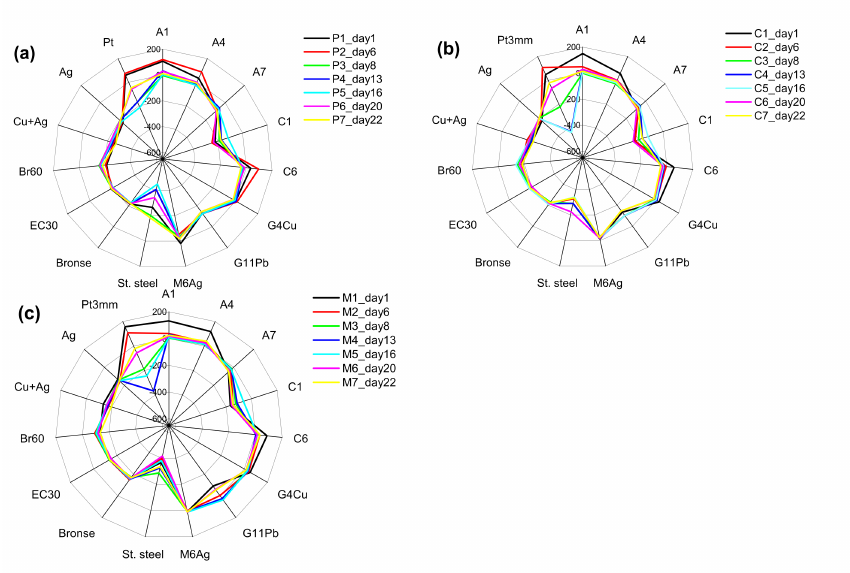
Figure 3. Potentiometric E-tongue data for ( a ) P. tricornutum, ( b ) Contaminant, and ( c ) Mix cultures filtrates over 22 day